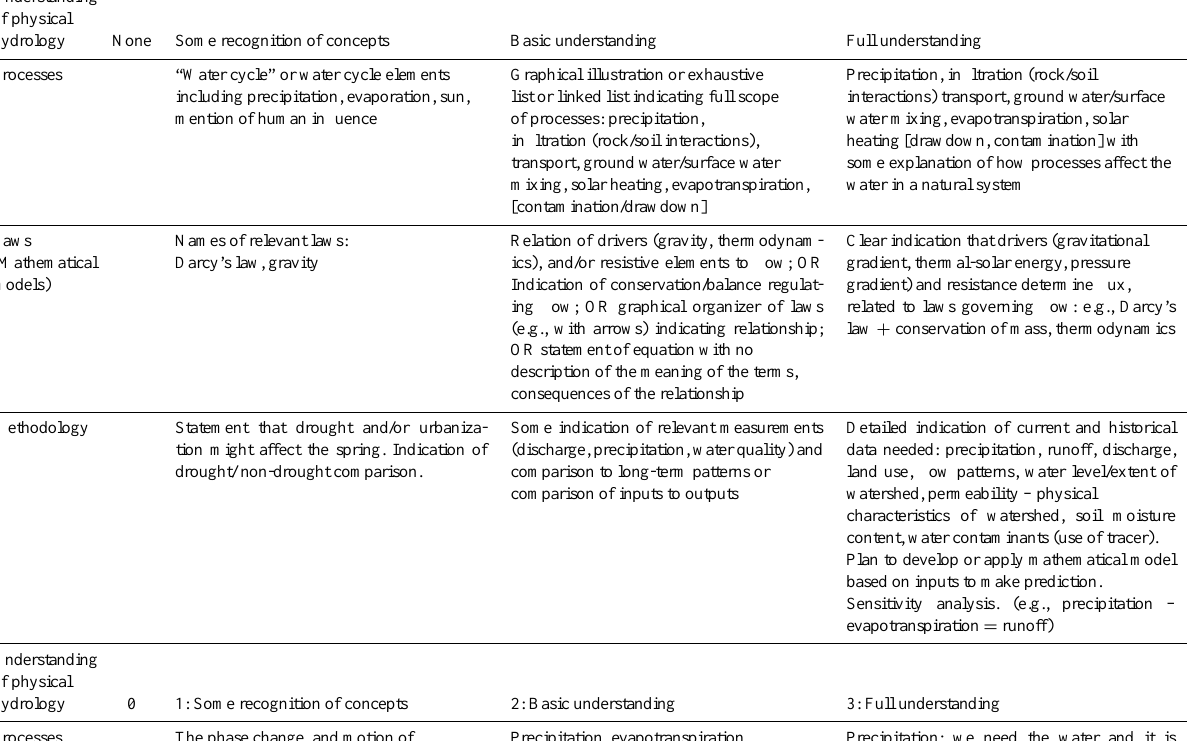
Table B1. Rubric and rubric